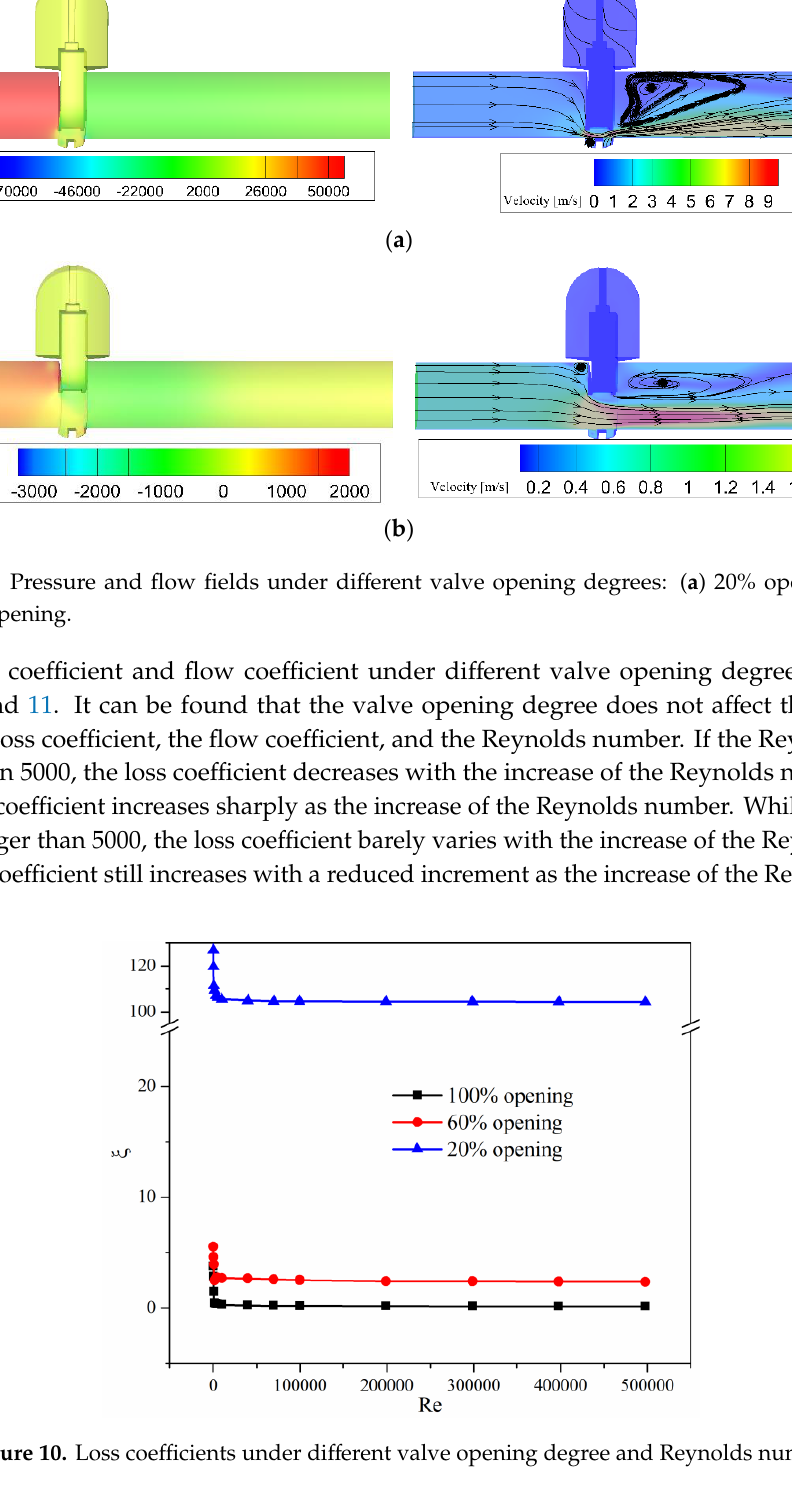
7 of 13 Figure 7. The flow coefficient with different Reynolds number. To investigate the internal flow and pressure fields, the pressure and velocity distributions on the symmetry plane when the Reynolds number is about 100,000 are shown in Figure 8. It can be found that, when the investigated gate valve is in the fully open position, the whole main pipe in the gate valve is full of water with high speed, and the main resistance of the gate valve is the channel for the movement of the disk. Thus, the pressure drop is relatively small if the gate valve is in the fully open position and the loss coefficient is close to zero. ( a ) ( b ) Figure 8. Pressure and velocity distributions on the symmetry plane: ( a ) Pressure distribution; and, ( b ) Velocity distribution. 3.2. Effects of Valve Opening Degree Figure 9 shows the internal flow fields and pressure distributions under two different valve opening degrees. Pressure drop mainly appears at the downstream of the gate valve that results from the throttling effect of two disks. With the decrease of the valve opening degree, the flow area decreases and the throttling effect increases, so the upstream pressure increases as the downstream pressure remains constant. Together with Figure 8, it can be found that, when the gate valve is in a 100% opening degree, the water flows directly to the downstream pipe, and there is no swirl in the